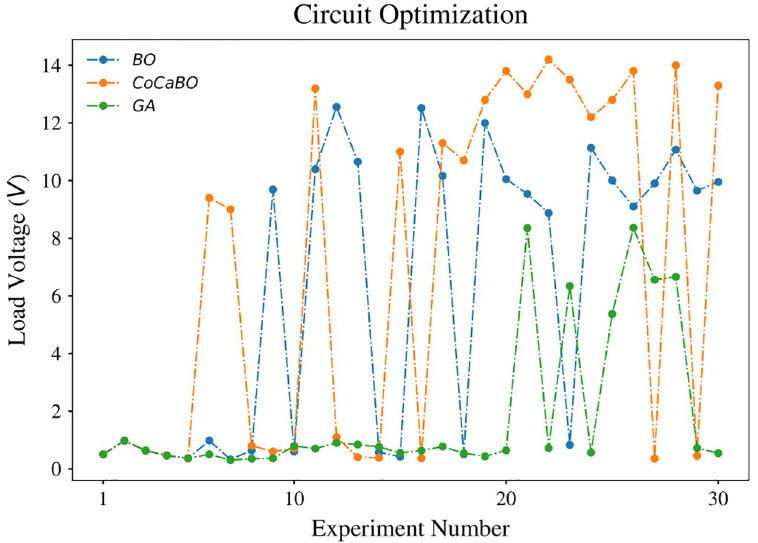
Fig 6. Result of circuit optimization with one obstacle. Patterns that make contact with the obstacle result in a low load voltage. Starting from low voltage values, CoCaBO achieves high load voltage values and outperforms both BO and GA (12.8% and 71.9% higher, respectively). While simultaneously coping with discrete and continuous choices GA shows the worst performance in this experiment.